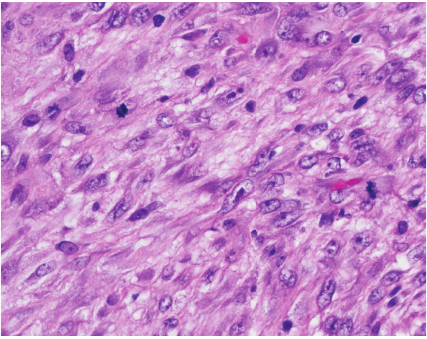
Figure 1: H&E staining of phyllodes